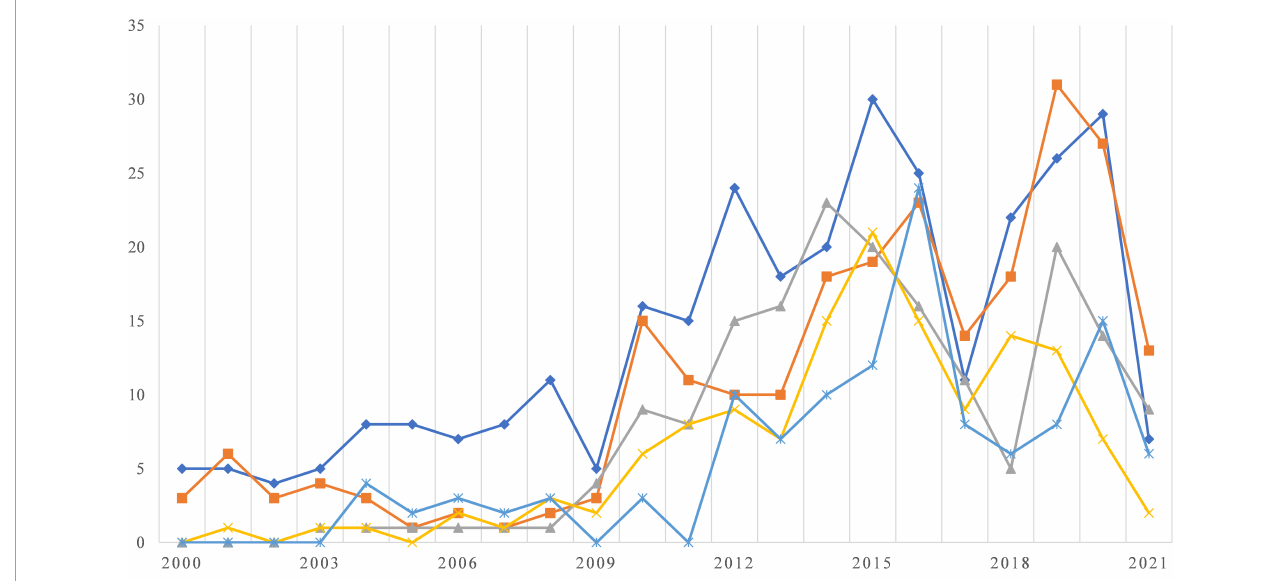
FIGURE4 Research foci trends related to basic research.